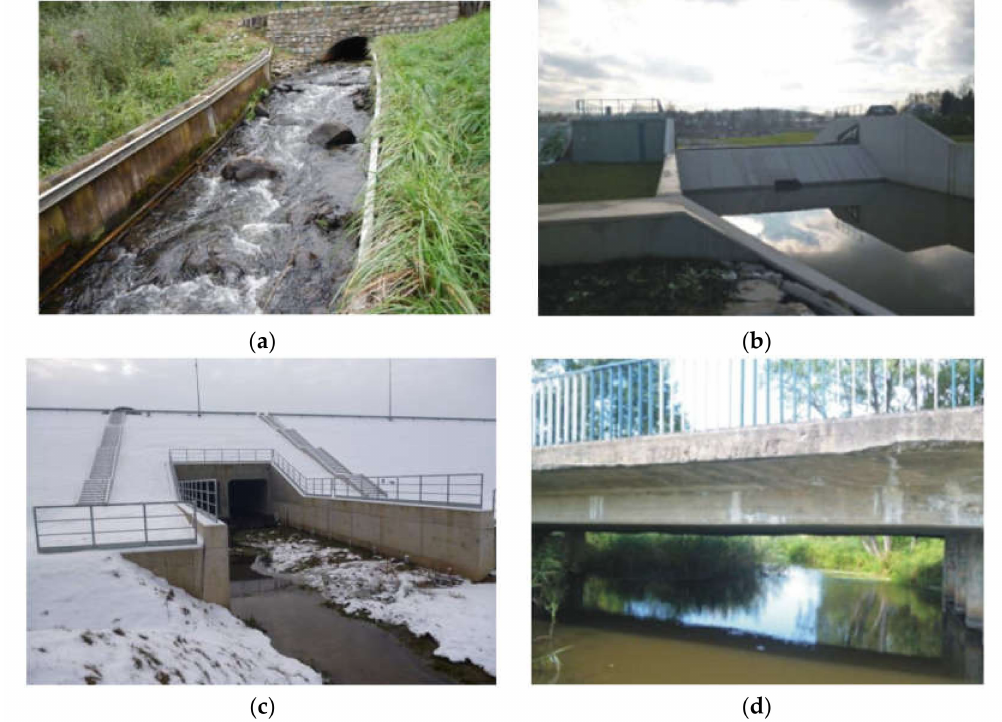
Figure 1. Examples of hydraulic structures where the proposed model can be used to assess design discharges: ( a ) culvert; ( b ) weir in small detention reservoir; ( c ) orifice in small retention reservoir; ( d )